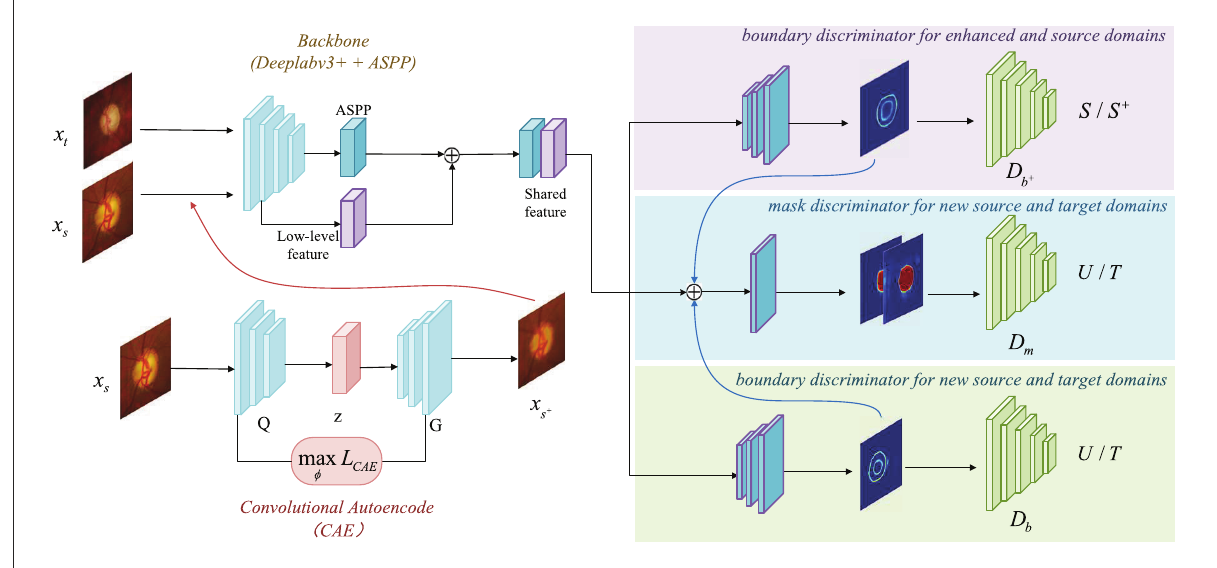
FIGURE2 Overview of CAE-BMAL framework for domain daptation. The backbone is based on the DeepLabv3+ (Chen et al., 2018) architecture with Atrous Spatial Pyramid Pooling (ASPP) component followed by the adversarial learning branch structure which is used to classify.